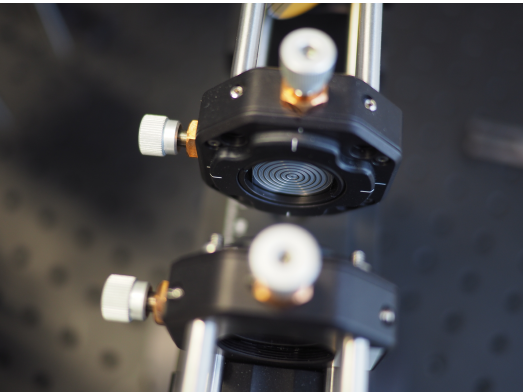
Figure 4. Photo of high-resistivity silicon-based Bessel zone plate placed in the optical mount. The diffractive optical element is prepared by the laser ablation technology. More details on fab- rication technology and the zone plate design can be found in Ref. [213]. Photo: courtesy of Do- mas